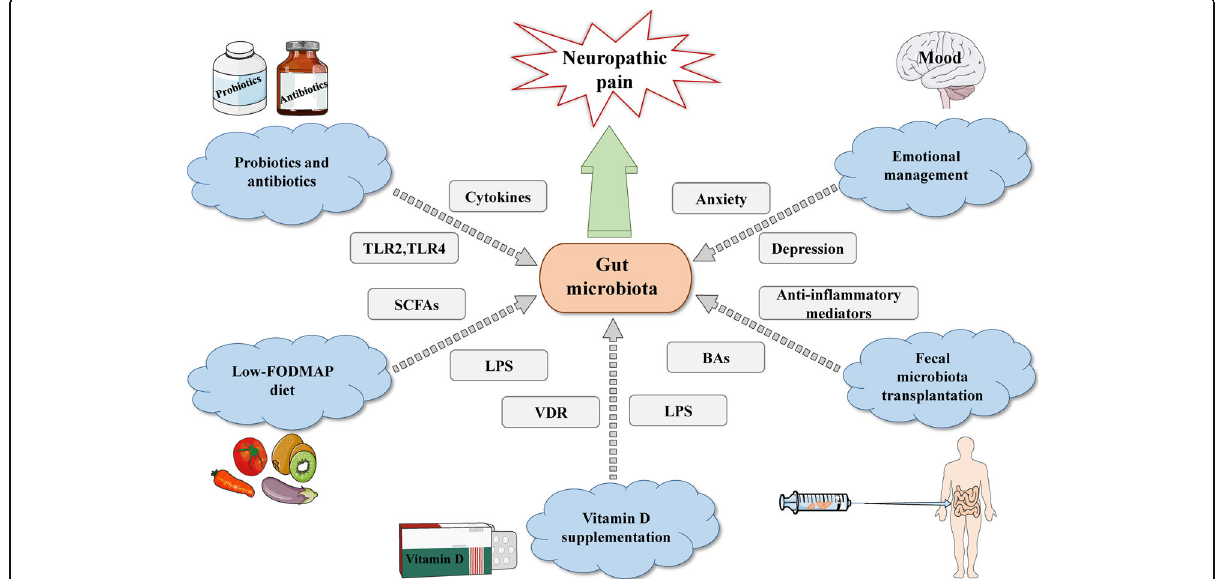
Fig. 3 The underlying therapeutic strategy for neuropathic pain through targeting of gut microbiota. There are primarily five therapeutic regimens consisting of probiotics and antibiotics, fecal microbiota transplantation, low-FODMAP diet, vitamin D supplementation, and emotional management for effectively relieving NP. The grey dotted line symbolizes potential mediators/influence factors. Abbreviations: TLR, Toll-like receptor; BAs, bile acids; LPS, lipopolysaccharide; SCFAs, short-chain fatty acids; FODMAP, fermentable oligosaccharides, disaccharides, monosaccharides, and polyols; VDR, vitamin D